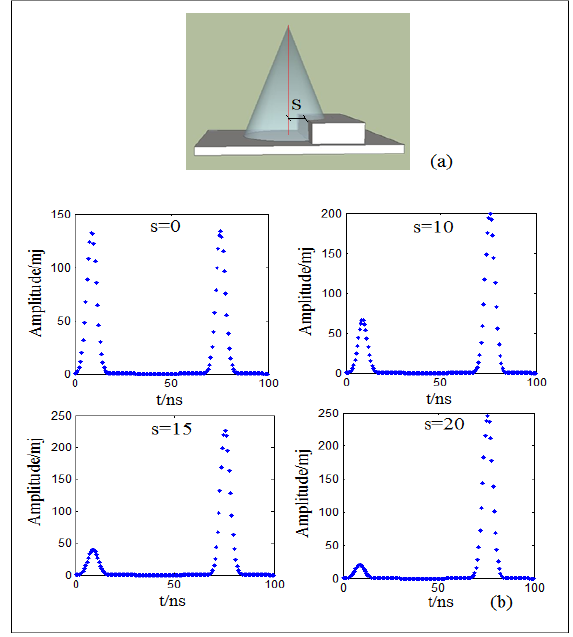
Figure 10. (a) Sketch map of the relative position between footprint and building; (b) The echoes of different building